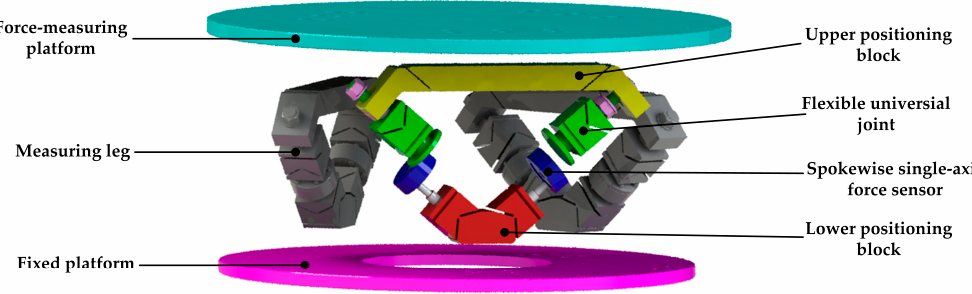
Figure 2. 3D Model of the 6-UPUR six-axis force sensor with flexible joints.